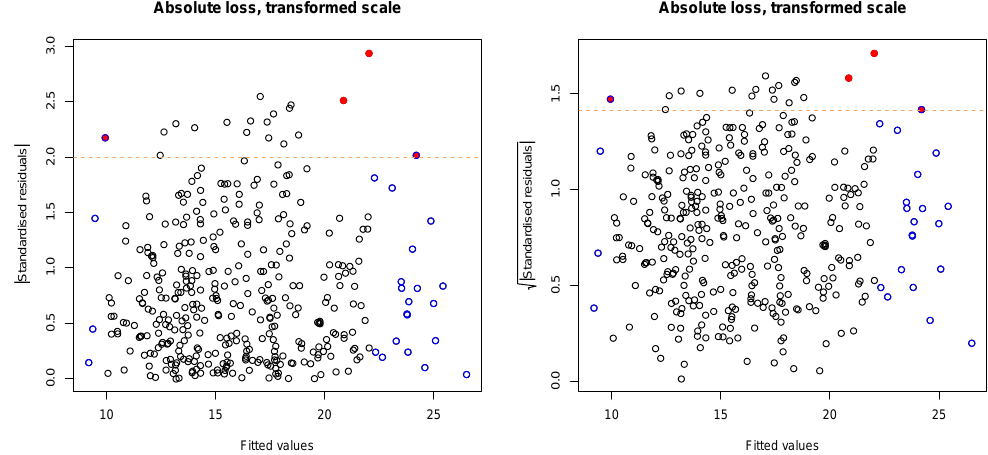
Figure A3. Diagnostic plots for the regression showed in Figure 3c. ( Top left ) Normal-Q-Q-plot, points along diagonal line don’t reject normality (SW: normality with a p -value = 0.245). All other figures show the fitted values on X-axis against the standardised residuals on the Y-axis as normal ( top right ), absolute ( bottom left ) and the square root ( bottom right ) of the absolute numbers. Blue borders indicate high leverage points, red filled circles indicate high values for Cook’s distance and the orange dashed lines indicate the borders to the definition of large residuals. Heteroscedasticity is not evident. One outlier (Bonferroni outlier test) is not shown in the plot. Appendix B.2